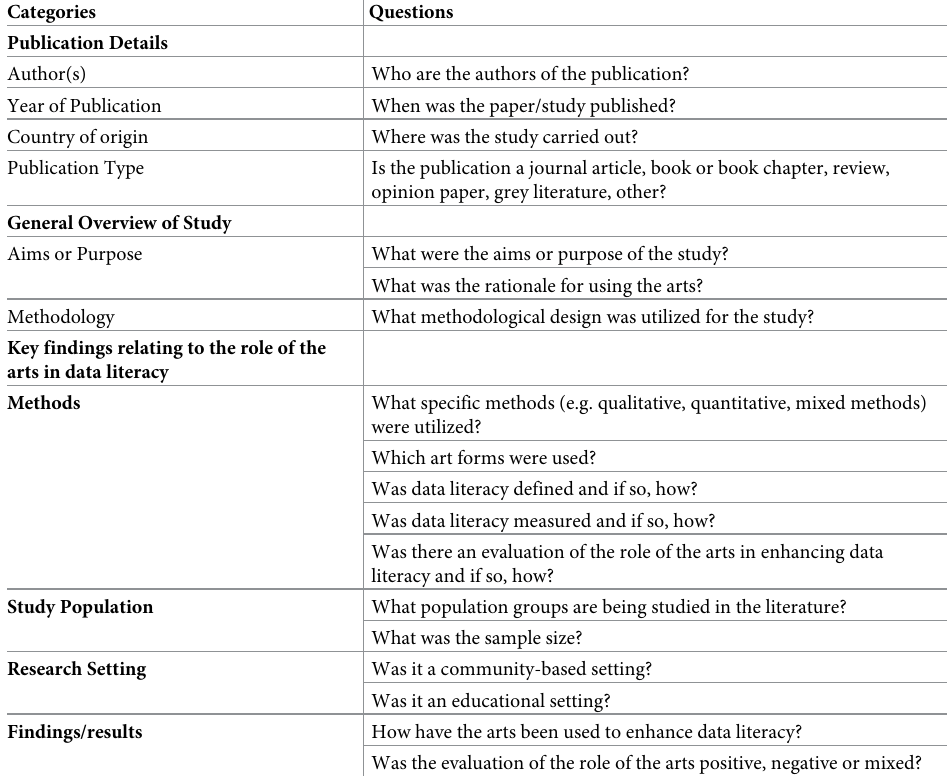
Table 5. Preliminary charting elements and questions (adapted from [23,